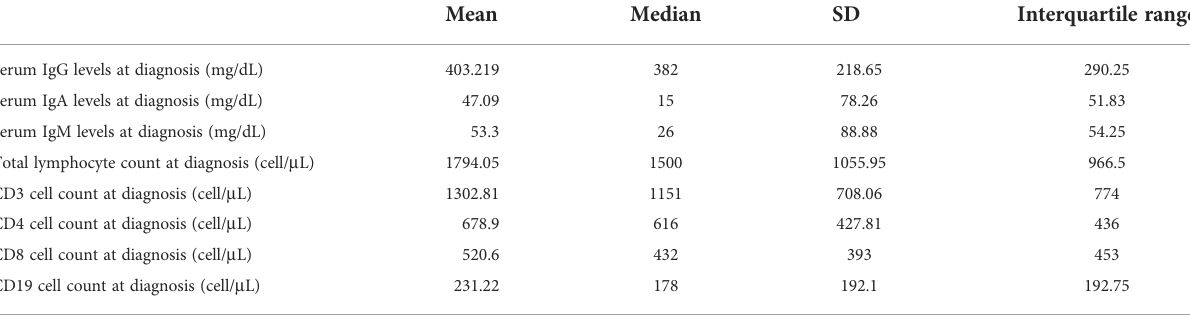
TABLE 6 Data on mmunoglobulin levels and lymphocyte subpopulations count in the GTEM-SEMI-CVID